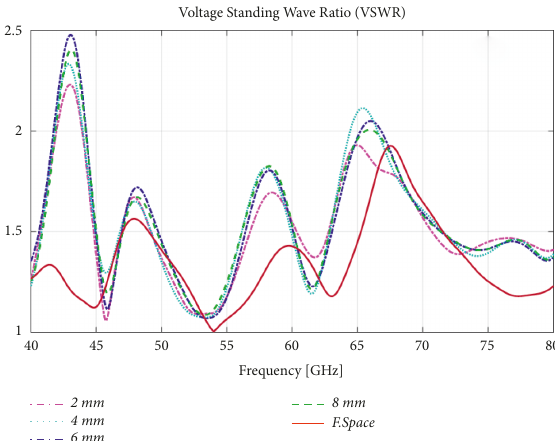
Figure 49: VSWR of 2 × 2 array antenna for different distances.